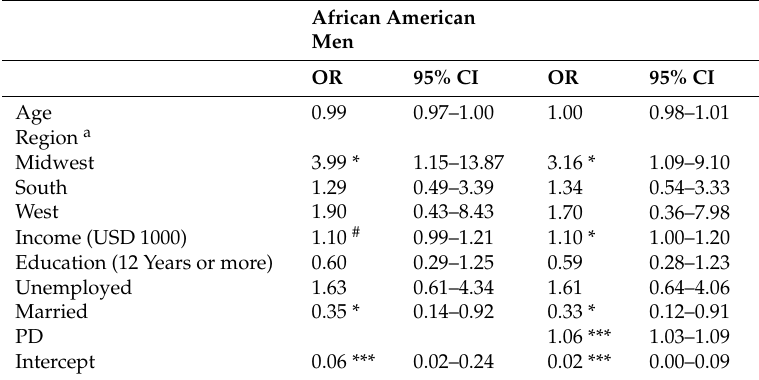
Table 2. Logistic regression on the effects of socioeconomic resources and perceived discrimination (PD) on risk of 12-month major depressive episode